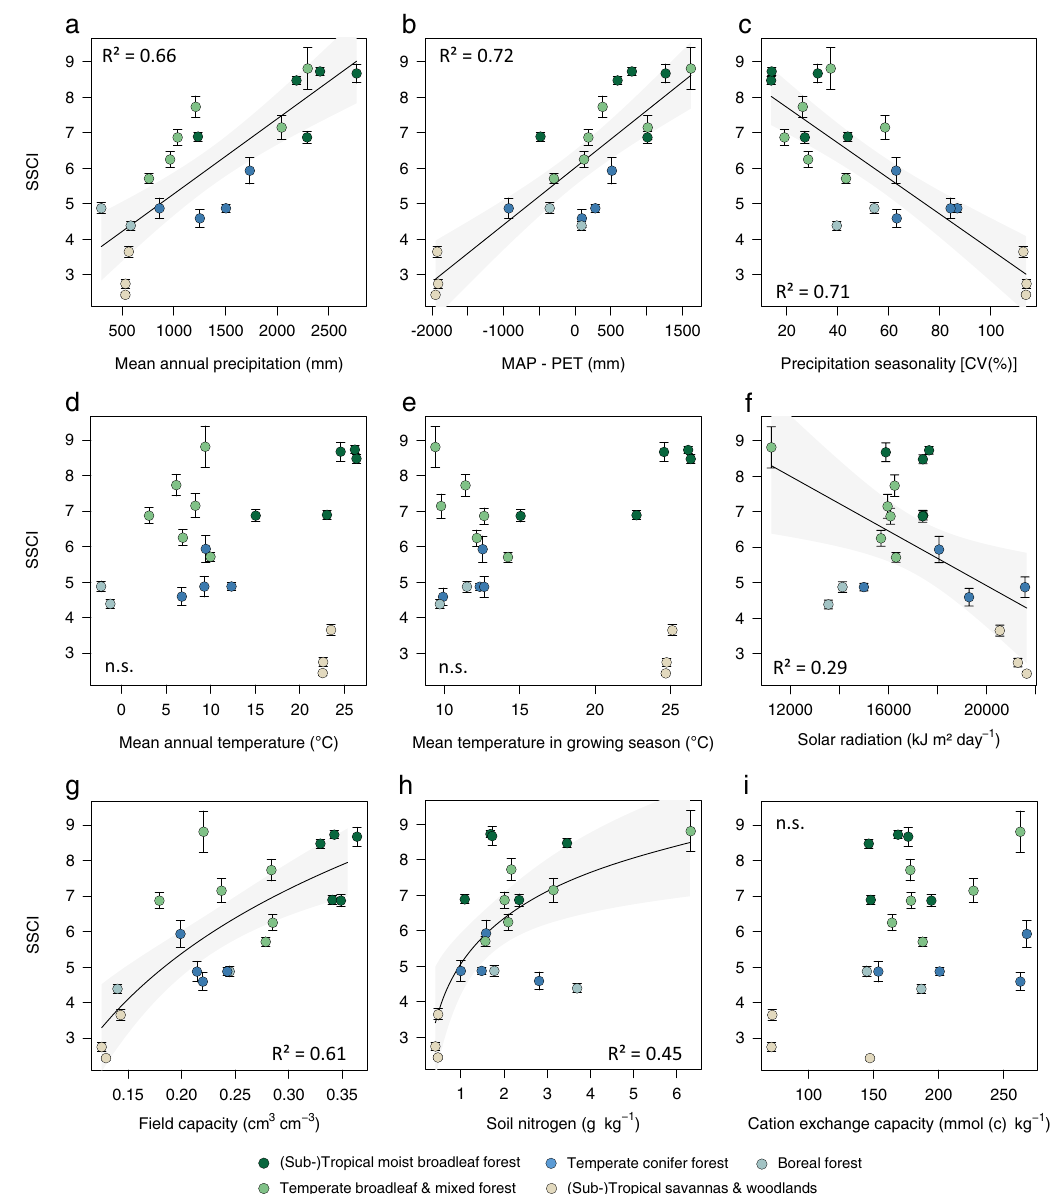
Fig. 2 Relationships of forest structural complexity (SSCI) with climatic and edaphic factors. Linear regression was used to model relationships between primary forest structural complexity, as quanti fi ed by the stand structural complexity index (SSCI) and a mean annual precipitation (mm), b water balance (MAP – PET in mm), c precipitation seasonality (coef fi cient of variation in %), d mean annual temperature (°C), e mean temperature during growing season (°C), f solar radiation (kJ m² ha − 1 ), g soil water holding capacity ( fi eld capacity in cm³ cm − 3 ), h soil nitrogen (g kg − 1 ), i cation exchange capacity (mmol (c) kg − 1 ). Data points represent mean SSCI values for each site ( n = 20 sites). Error bars indicate the standard error of the mean SSCI per site. Number of plots per site are shown in Table 3. Shaded envelopes represent the 95% con fi dence interval of the regression